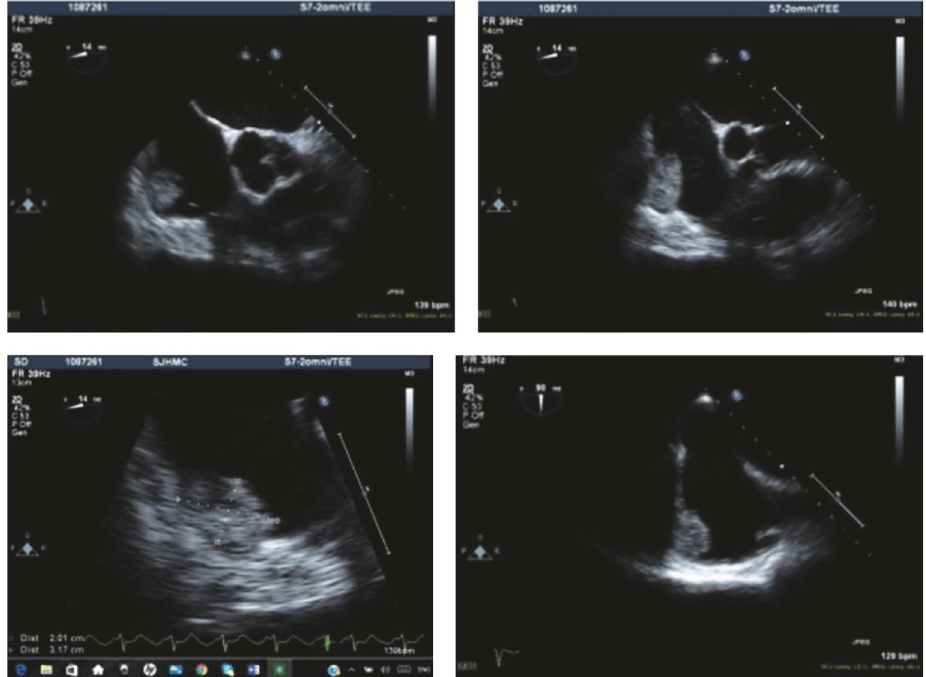
Figure 3: Aortic valve short axis and bicaval views of TEE showing right atrial mass at the junction between the SVC and the right atrium.